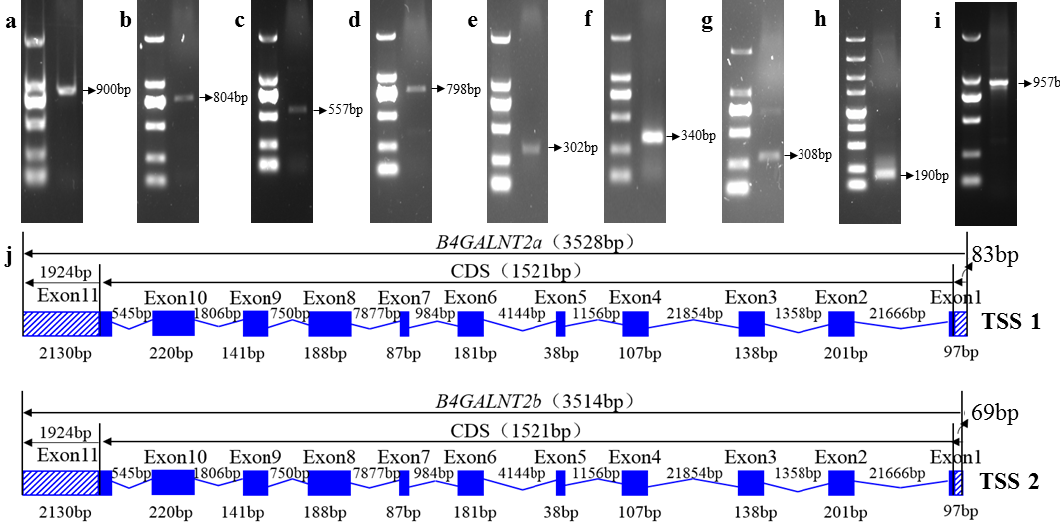
Figure 2. Full-length sequence of B4GALNT2 . ( a ) Partial cording sequence amplified by P4. ( b ) Partial cording sequence amplified by P5. ( c ) Partial cording sequence amplified by P6. ( d ) Partial cording sequence amplified by P7. ( e ) Partial cording sequence amplified by P8. ( f ) Partial cording sequence amplified by P9. ( g ) 5′RACE product for the transcript of B4GALNT2a . ( h ) 5′RACE product for